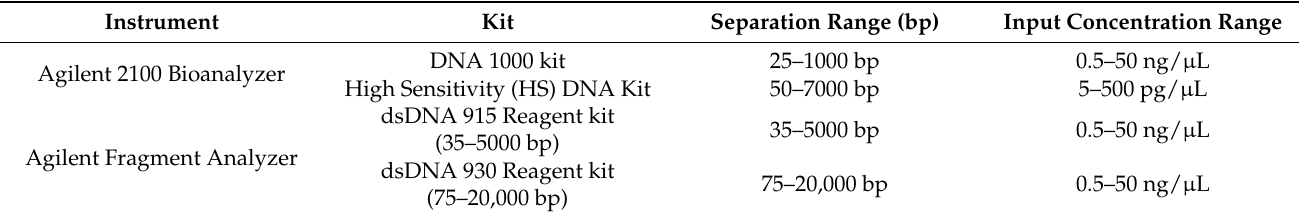
Table 1. Automated DNA sizing methods used in this